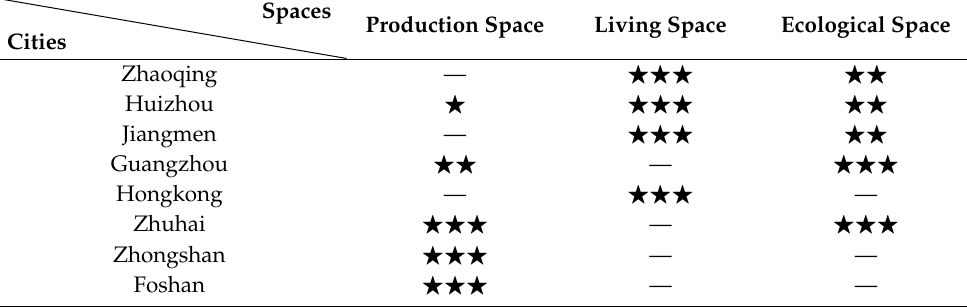
Table 8. Production-living-ecological space optimization plan for prefecture-level cities with declin- ing levels of sustainable development.